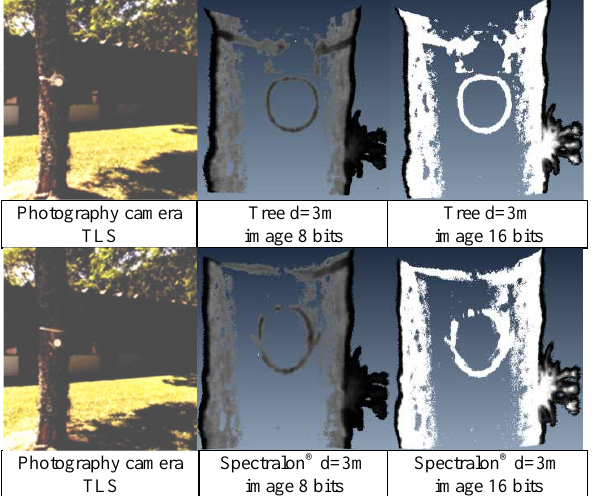
Figure 4. Images produced by the intensity of the TLS 3m target with 0.5mm spacing between points and radiometric resolution of 8 and 16 bits.